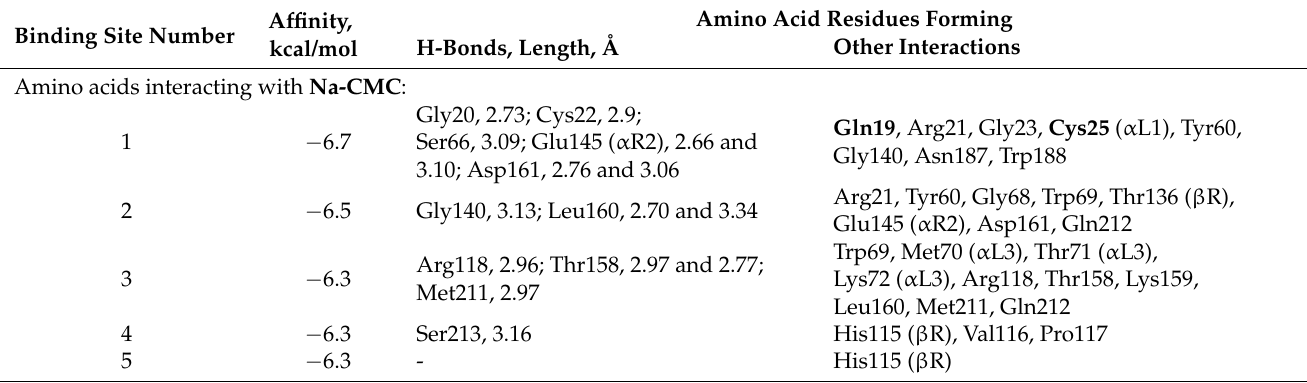
Table 1. Ficin amino acids interacting with ligands